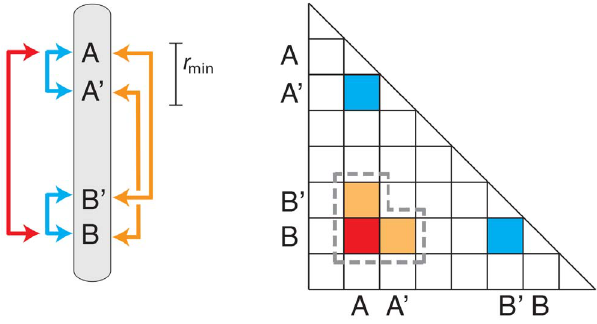
Figure 1. Schematic of the structure of long range linkage disequilibria. Right: Sites A and B are the target of selection or other force that generates disequilibria between them (red arrow). Site A is in disequilibrium with site A 9 nearby as the result of shared ancestry of that small segment of chromosome; likewise B and B 9 also show short range disequilibrium (blue arrows). Right: A triangle plot of LD. Disequilibria between nearby sites appear as the band along the diagonal. The dash line encloses a ‘‘patch’’ consisting of pairs of widely- separated SNPs that are in LD.